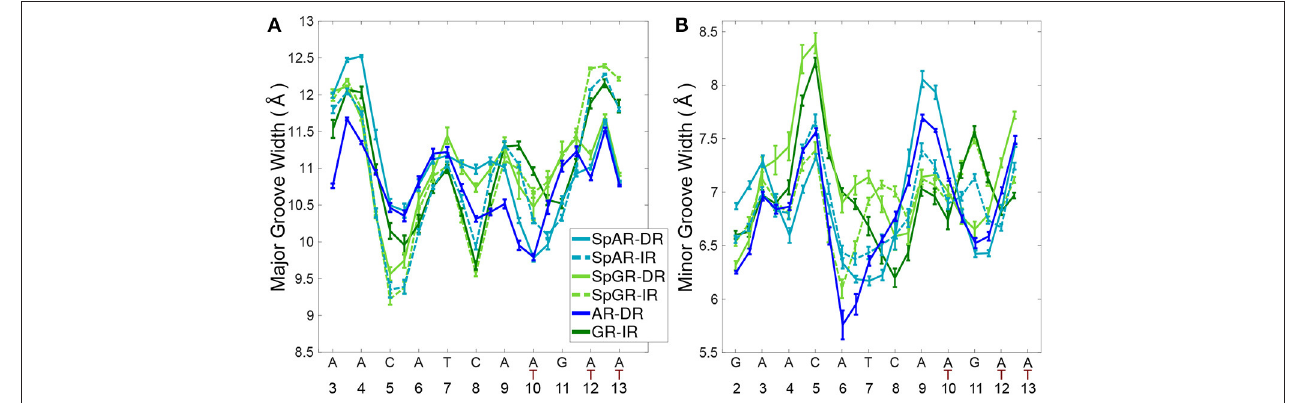
FIGURE 6 | The DNA (A) major groove and (B) minor groove widths for all systems.